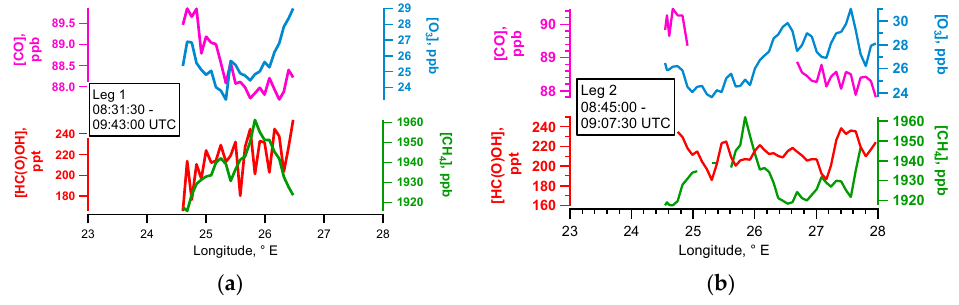
Figure 10. The concentration trend for HC(O)OH, CH 4 , O 3 and CO travelling; ( a ) ~78 km along transect x during flight B797 at 08:31:30–08:43 UTC (leg 1), ( b ) ~147 km along transect x during flight B797 at 08:45–09:07:30 UTC (leg 2).